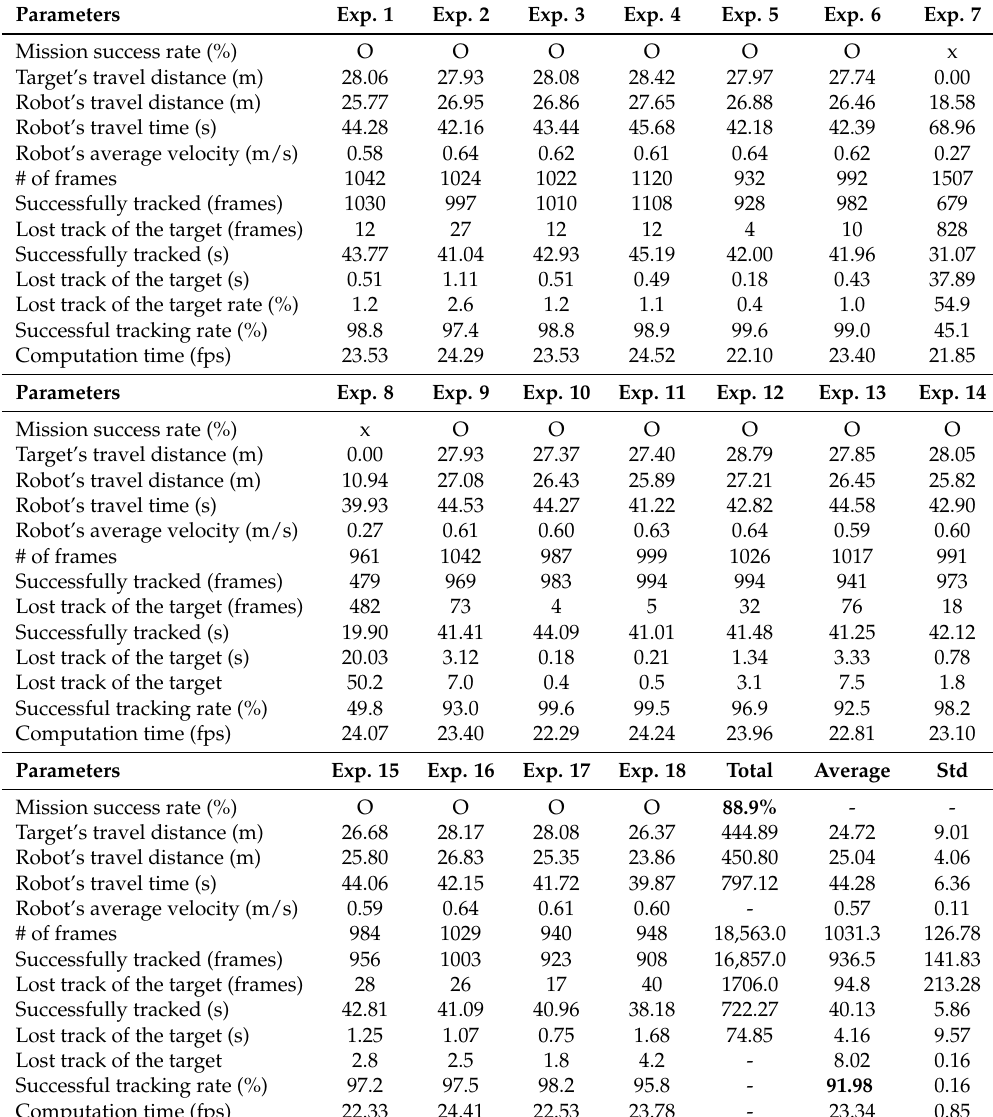
Table 1. Experimental results of human